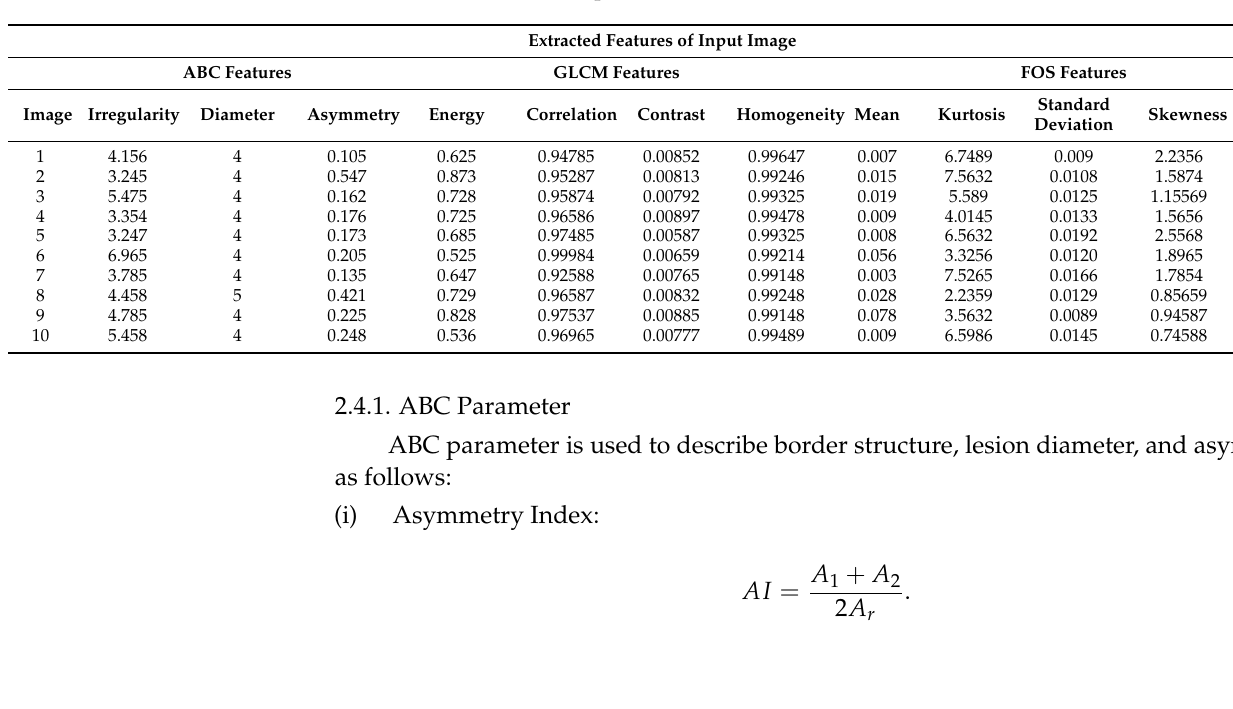
Figure 6. Segmentation results after applying the GCPSO algorithm. Table 3. Extracted feature parameters for ABC, GLCM and FOS